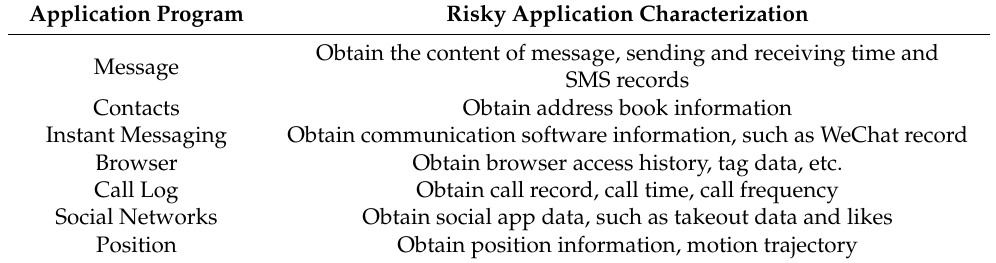
Table 1. The risky application characterization table.